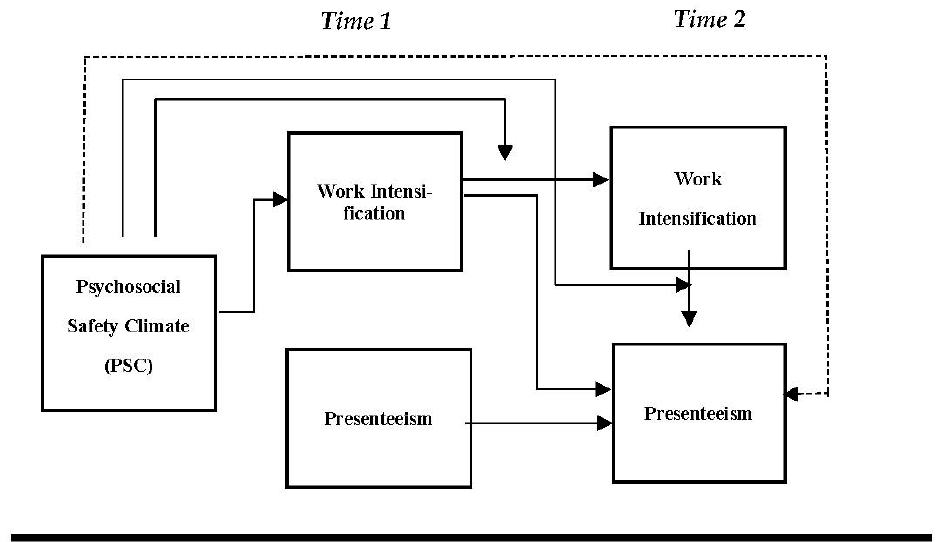
Figure 1. Conceptual model for Psychosocial Safety Climate (PSC), work intensification (WI) and Presenteeism (PRTSM).